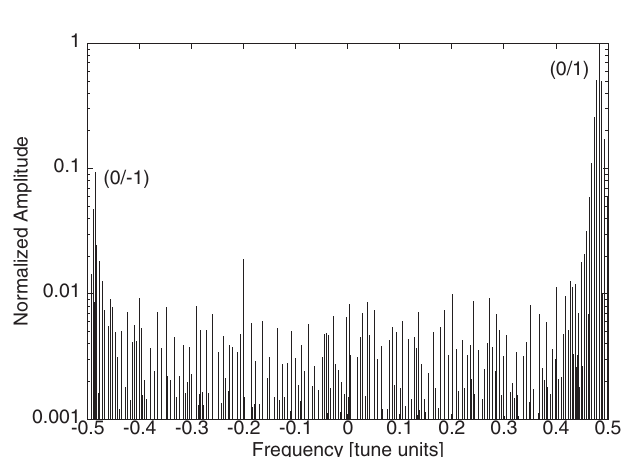
FIG. 27. Beam intensity without